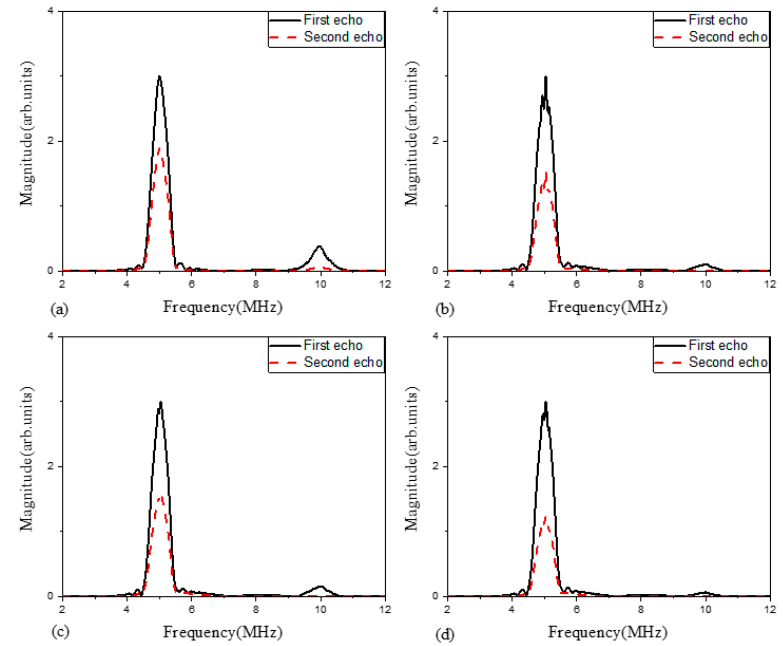
Figure 8. Spectrums of ultrasonic testing results for brass plates at four different stages: ( a ) raw material, ( b ) sample after annealing at 600 °C for 12 hours, ( c ) sample after re-cold rolling, and ( d ) sample after re-annealing at 600 °C for 12 hours.